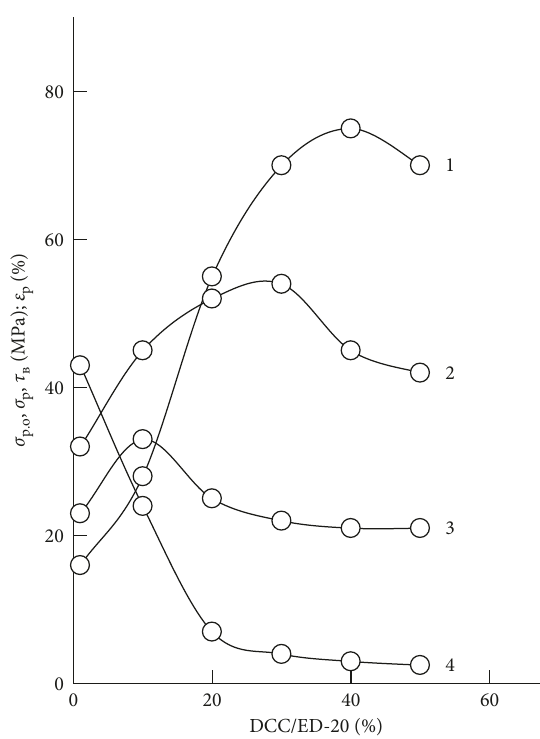
Figure 11: Dependence of the mechanical and adhesion proper- ties of polymers obtained on the basis of the E-181 +DCC/ED- 20+DETA compositions on the modifier concentration: σ r (1), τ c (2), σ r .o (3), and ε r